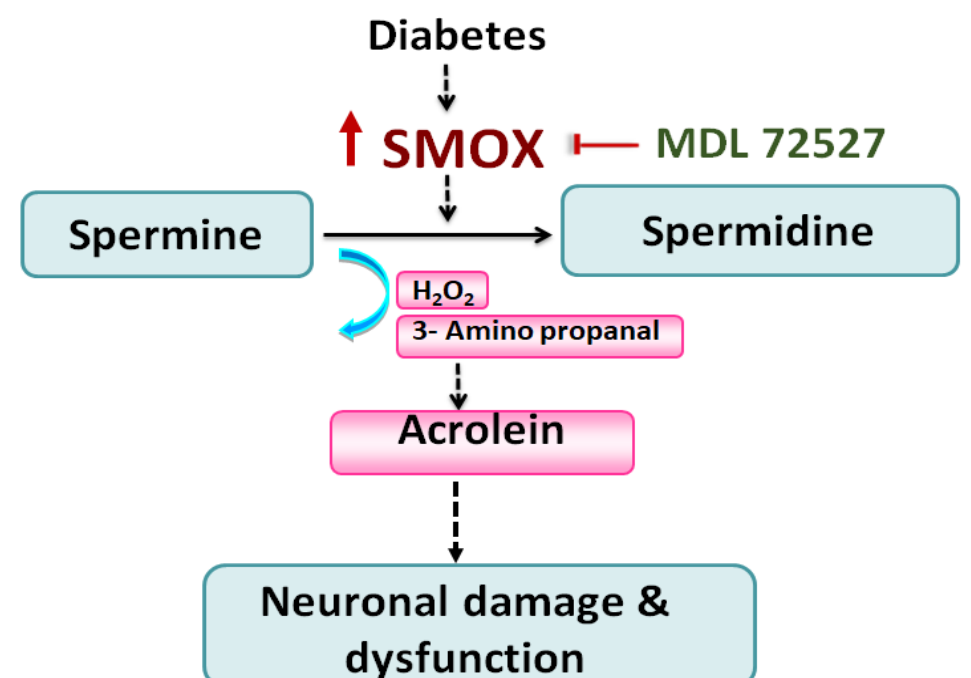
Figure 8. A proposed mechanism of SMOX-induced neurodegeneration in the diabetic retina. It is postulated that diabetes-induced upregulation of SMOX causes oxidation of spermine to spermidine, resulting in elevated levels of reactive aldehydes and H 2 O 2 . The reactive aldehyde, 3-aminopropanal (3-AP), gets converted to acrolein, a potent mediator of oxidative damage leading to neuronal damage and dysfunction in the retina. SMOX: Spermine oxidase; MDL 72527: N1, N4-bis(2,3-butadienyl)-1,4-butanediamine; H 2 O 2 : hydrogen peroxide.